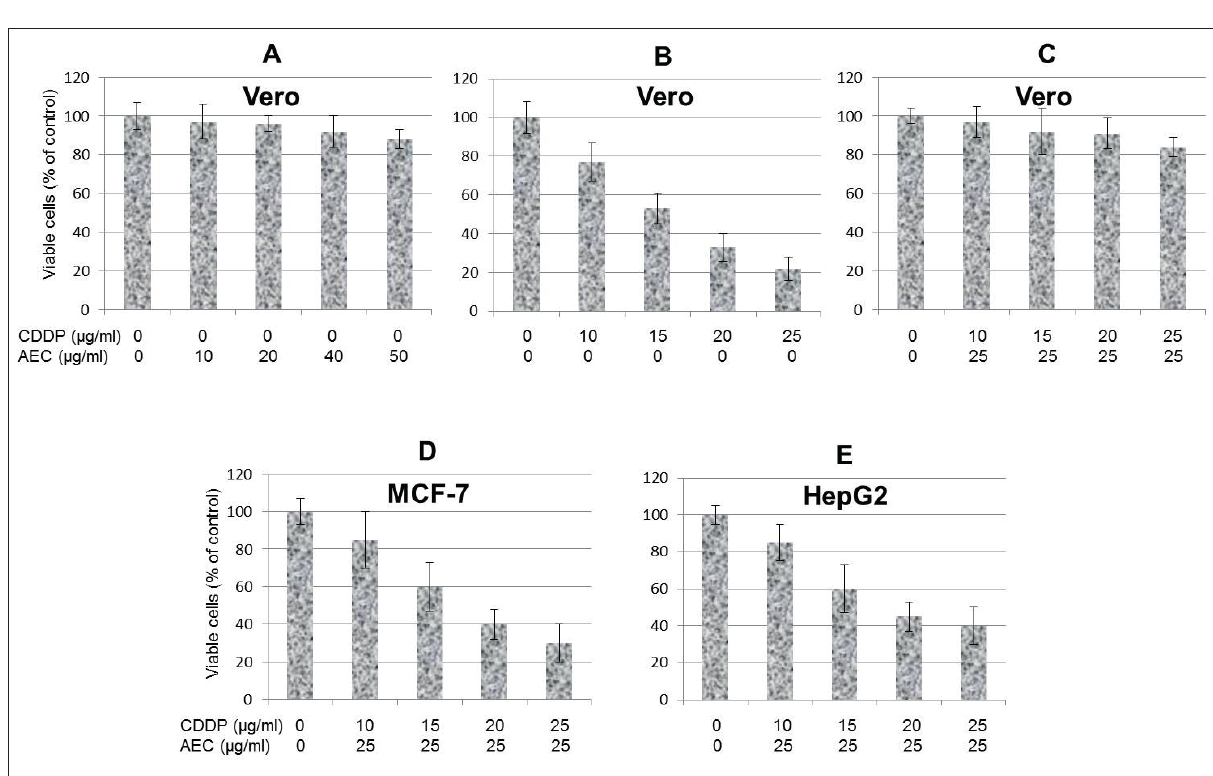
Fig. 1. aec prevented cddp-induced Vero cell Toxicity without compromising the anticancer efficiency of cisplatin. Viability of Vero cells (a, B and c) were assayed after treatment with either aec, cddp or combination of both aec and cddp for 24 h. Viability of mcF-7 breast (d) and HepG2 hepatocellular (e) cancer cells were assayed after treatment with combination of aec and cddp for 24 h. The experiments were repeated three times in triplicates, and values are reported as the mean ±